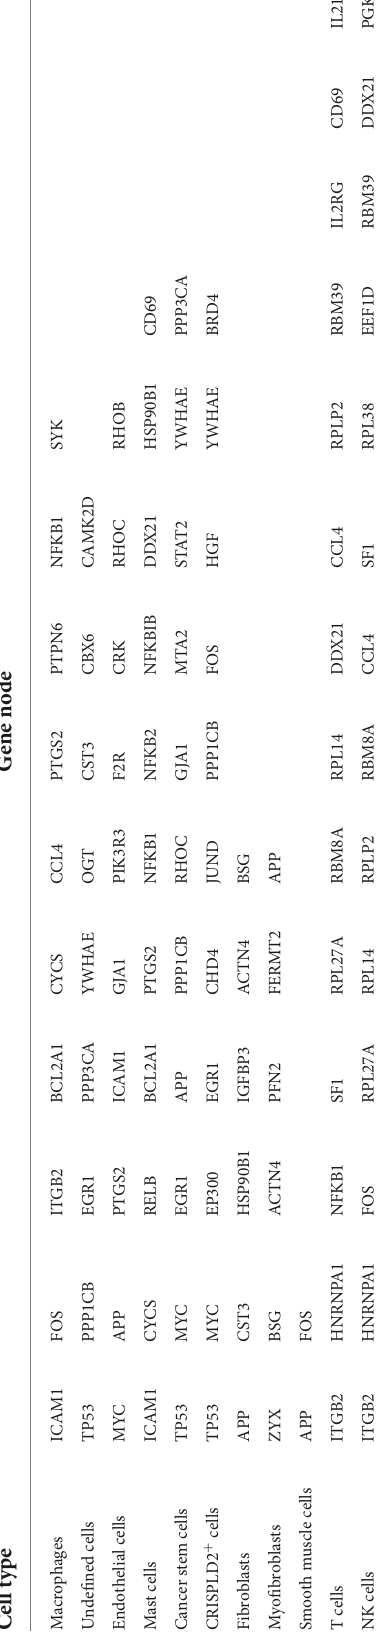
was converted into the gene symbol. Probes that did not correspond to the gene symbol were removed. For different probes mapped to the same gene, the mean value of the probes was taken as the final gene expression